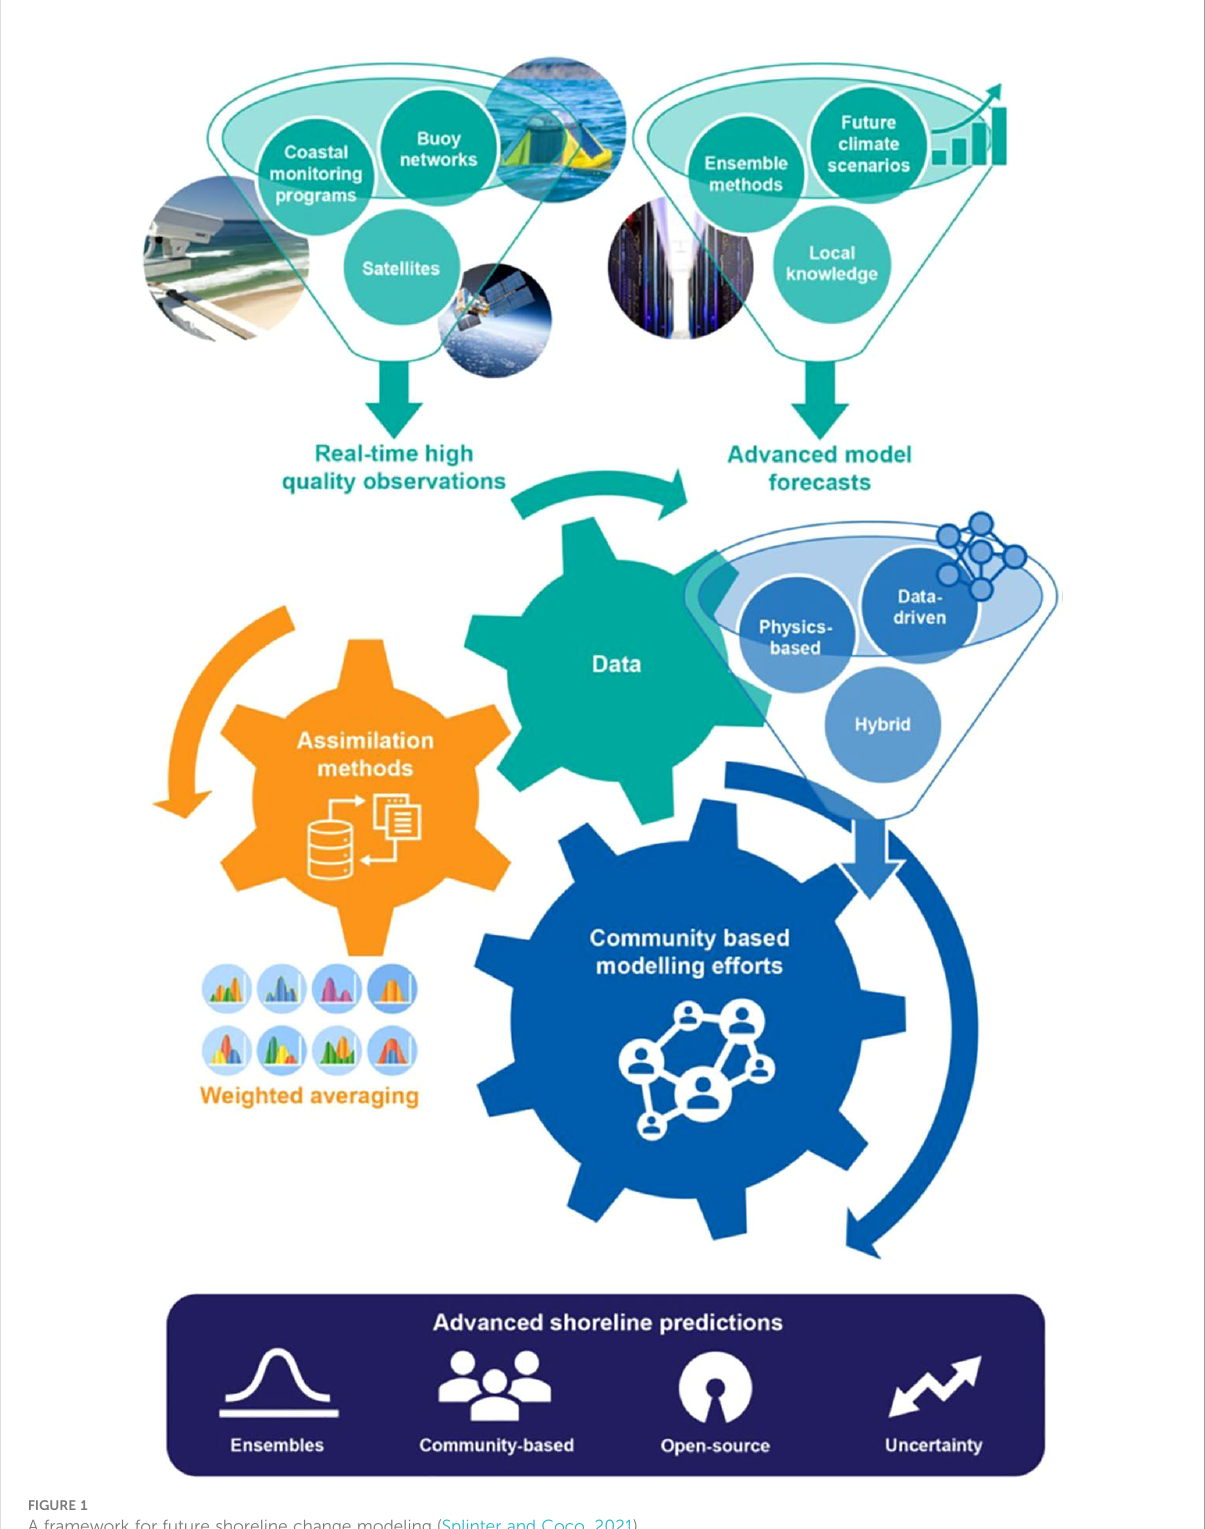
FIGURE 1 A framework for future shoreline change modeling (Splinter and Coco,